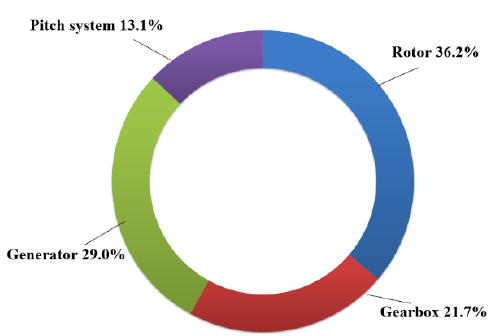
Figure 7. The proportion of cost savings.